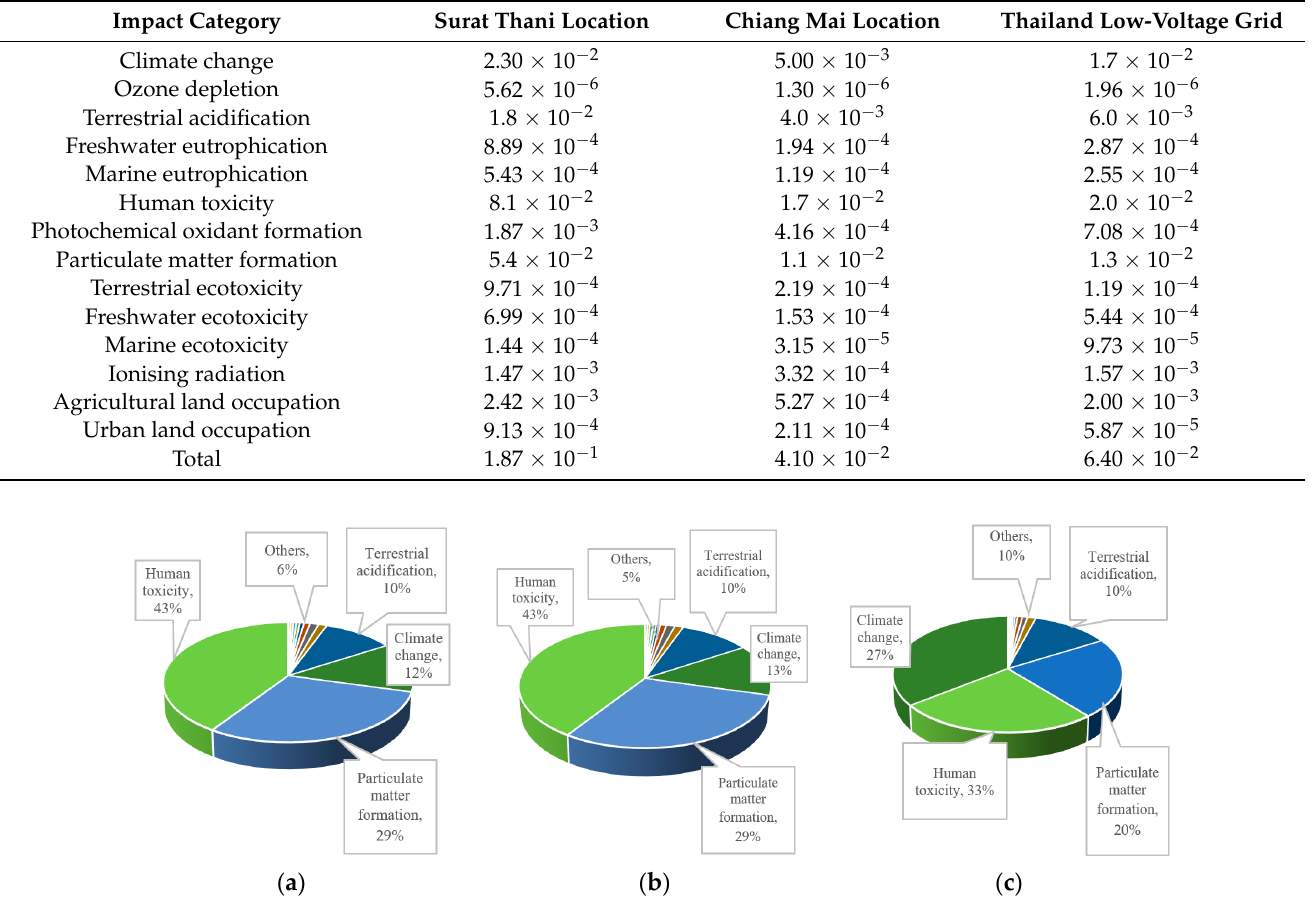
Figure 7. Environmental prices, percent of total impact cost for: ( a ) S. T. ( C F = 1.65%); ( b ) C. M. ( C F = 7.58%); ( c ) Thai grid. The four largest value impacts are labelled. For the smaller impacts, see Table 9.